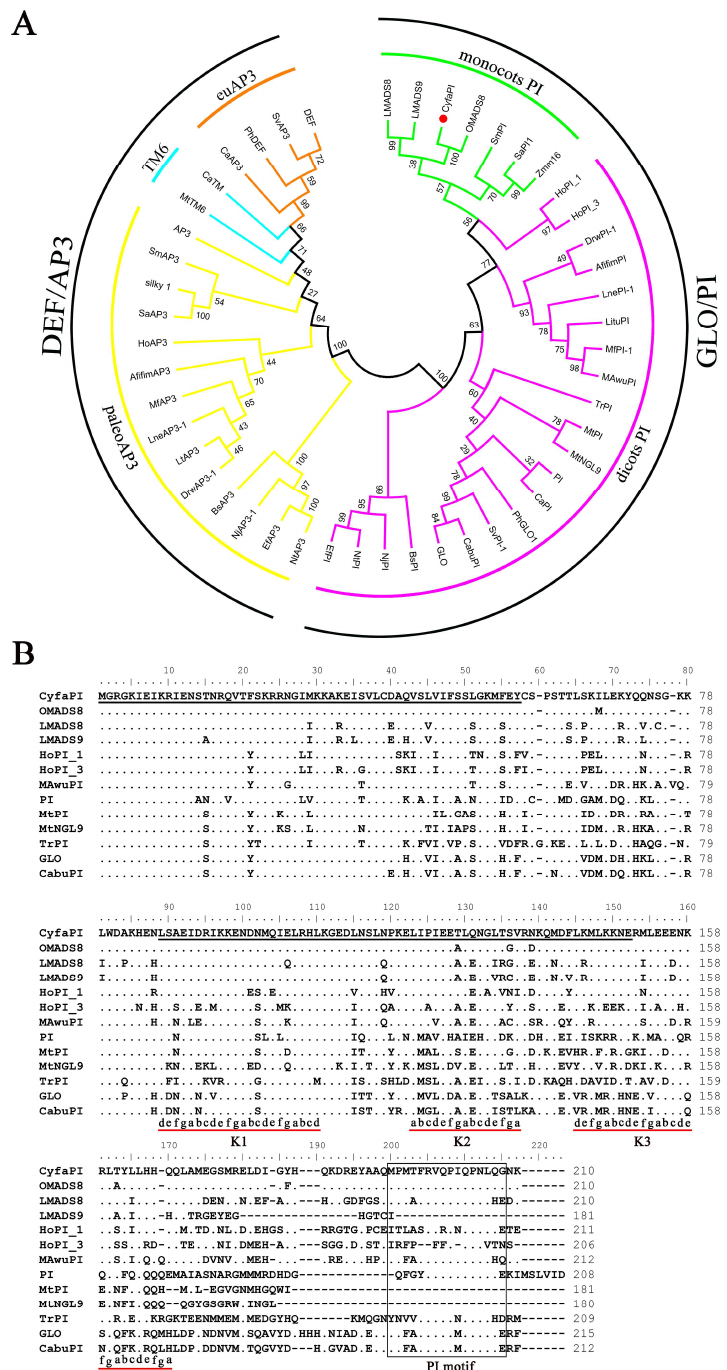
Figure 2. Phylogenetic analysis and sequence alignments of CyfaPI with B-class MADS-box proteins from other plant species. ( A ) Phylogenetic analysis of B-class MADS-box proteins; ( B ) Sequence alignments of CyfaPI with PI-like proteins from other plant species; the first underline indicates the MADS-box domain and the second the K domain. The PI motif in the C-terminal region is boxed. Dots represent amino acids (aa) identical to CyfaPI. Dashes indicate gaps inserted to improve the sequence. The K1, K2 and K3 helices with the (abcdefg) n heptad repeats are also underlined.